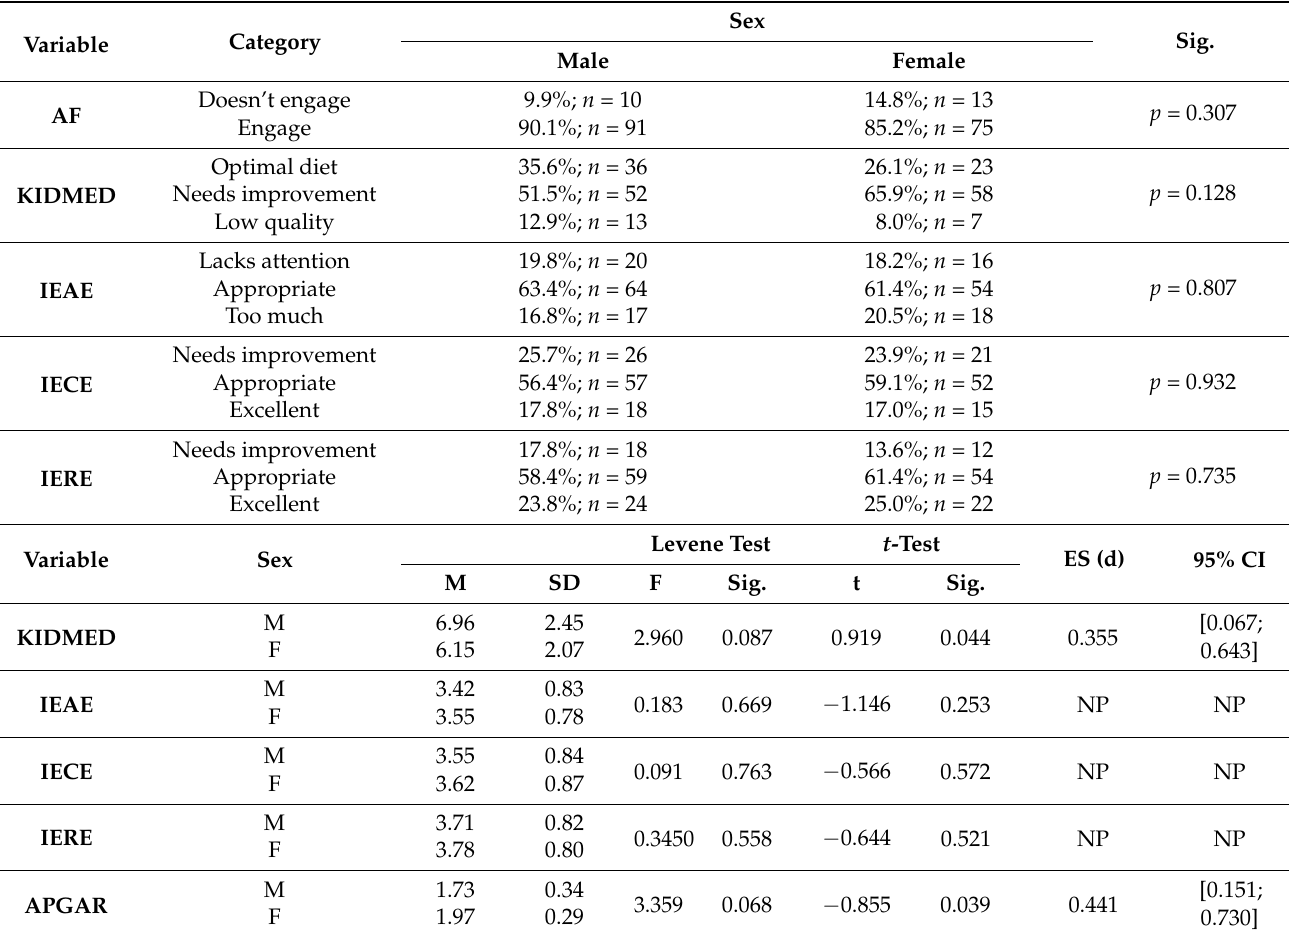
Table 5. Relational study according to the sex of participants.